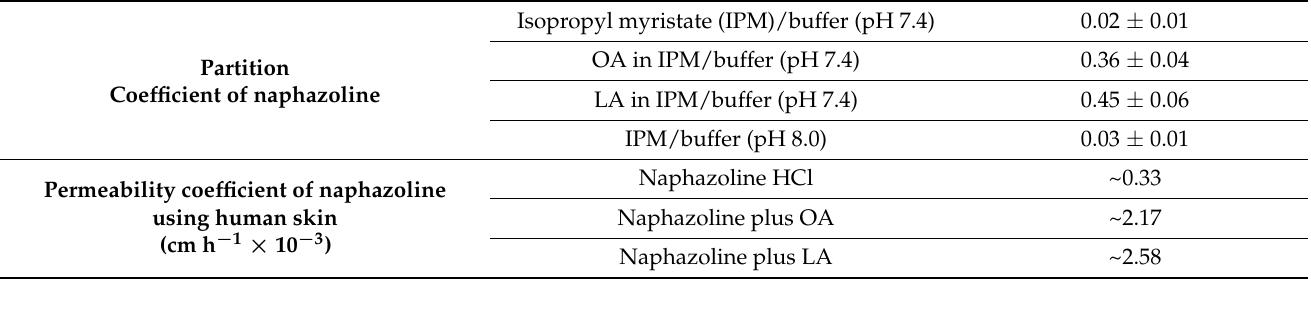
Table 1. Impact of OA and LA on the PC and permeability coefficient values for naphazoline. Concentration of naphazoline applied was 0.05 M ( n = 4, values represent the mean ± S.D.) Adapted with permission from [28], Elsevier, 1988.